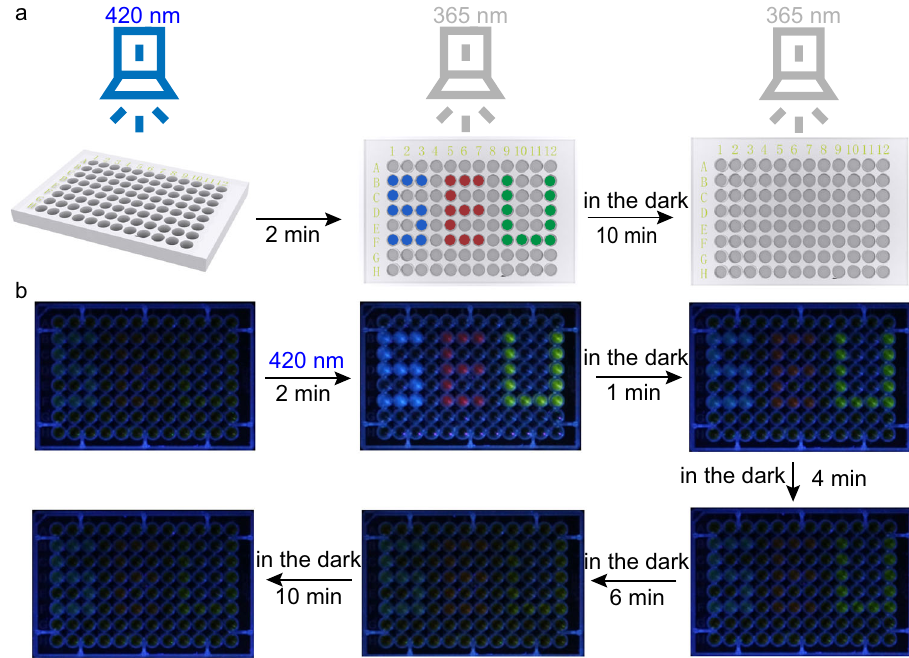
Fig. 9 Dynamic fl uorescent exhibition in 96-well plates. a Schematic representation of the 420 nm light writing and 365 nm emitting the patterns in the 96-well plates. b The gradual fl uorescence change with time in the dark after 420 nm irradiation. ([SMC] initial = 0.225 mM, [PEI] = 5 μ g mL − 1